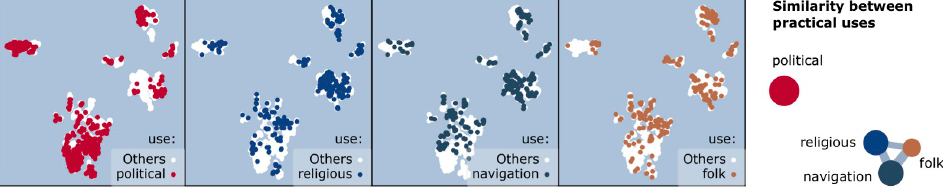
Fig 7. Visual signatures by practical use (question I.3). (top) Constellations per use are shown in the foreground, over the background of all other constellations. (bottom) The similarity graph between practical uses. The node size is proportional to the number of constellations per use, and the edge width to the similarity Δ